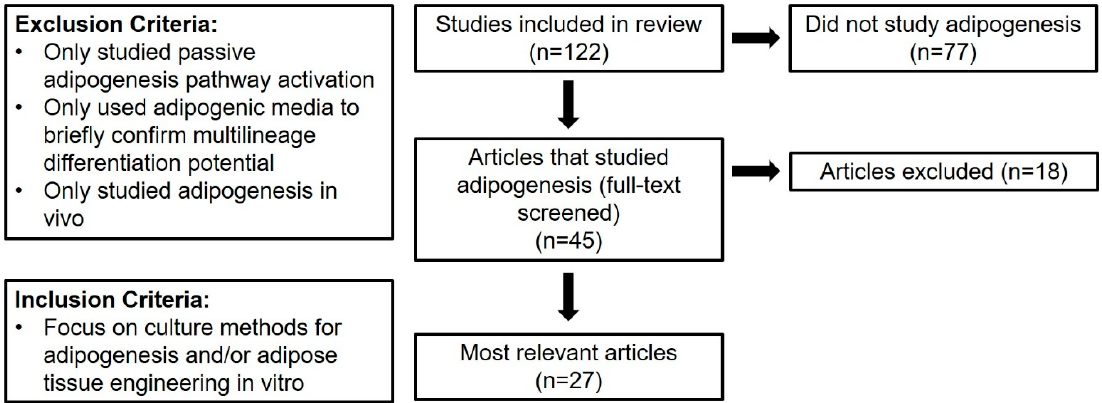
Figure 4. Flow diagram of selection process to identify articles that are most relevant to the present review. These articles focus on intentional human adipose-derived stromal/stem cells (hASC) adipogenesis and adipose tissue engineering in vitro.